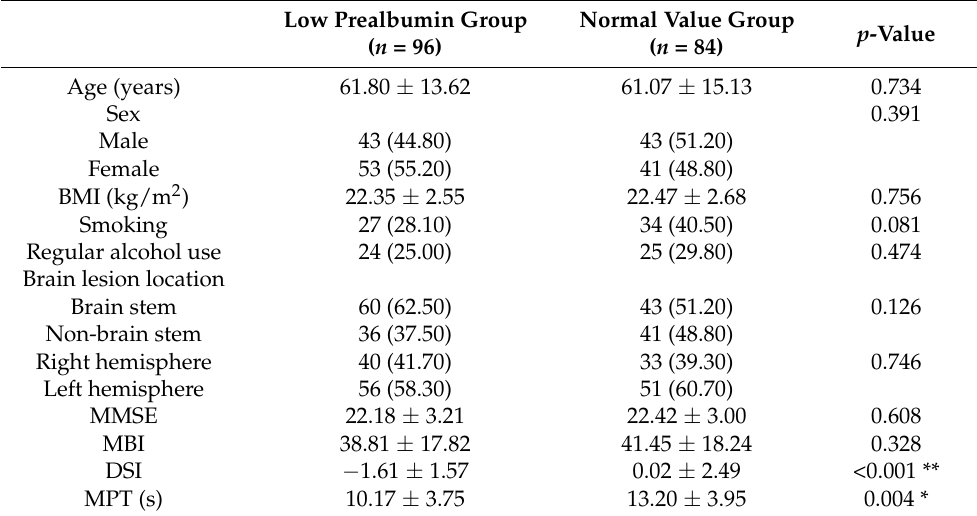
Table 4. Comparison of characteristics between the low prealbumin group and the normal value group.